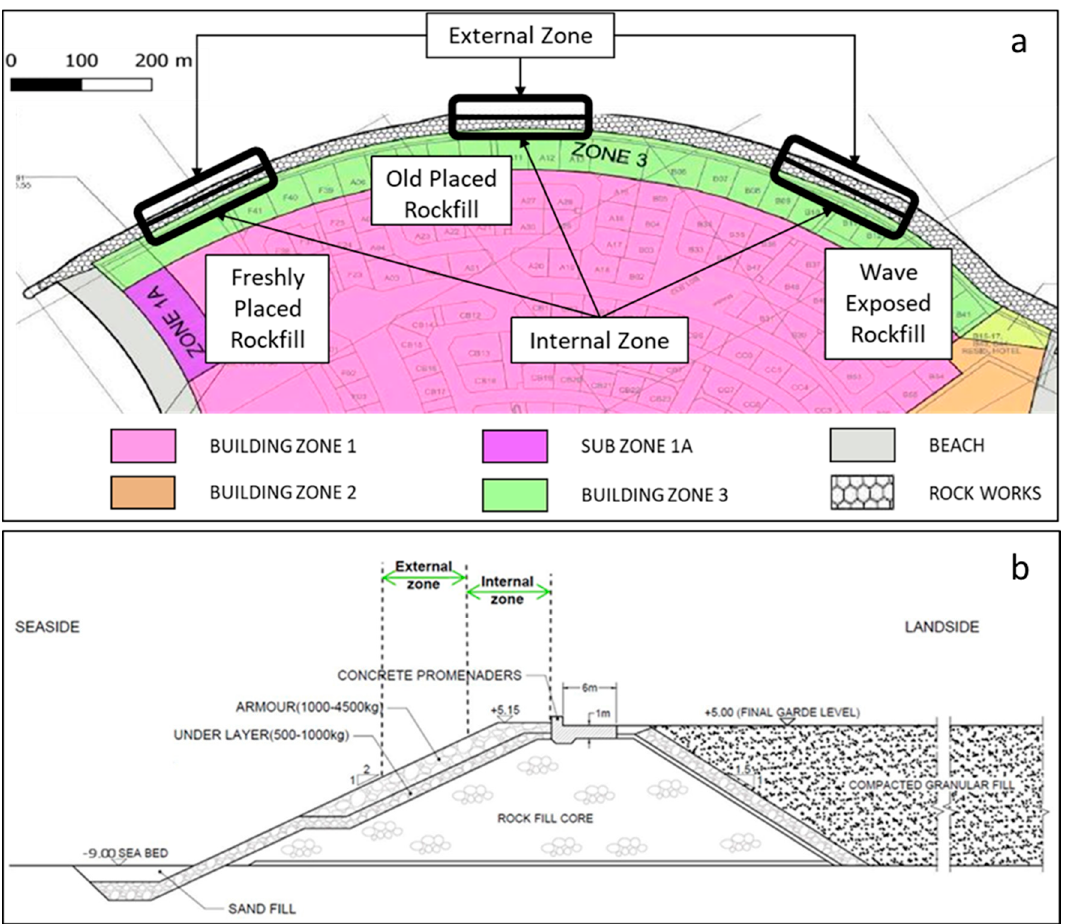
Figure 2. Plan view of the studied areas ( a ) [29] and typical cross-section in the outer revetment after end of construction and removal of preloading with fill embankment ( b ).